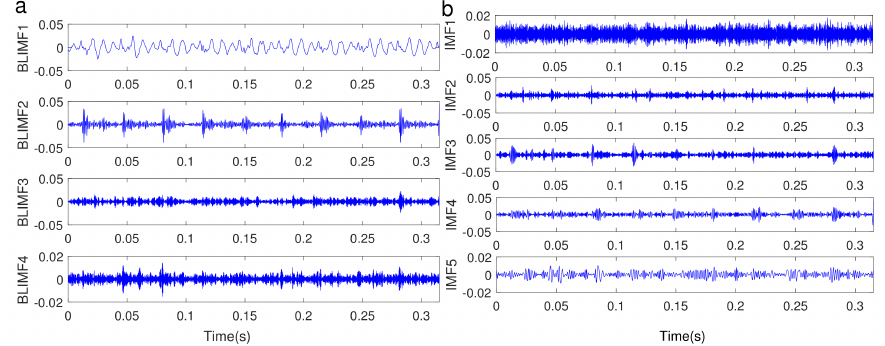
Figure 14. The decomposed BLIMFs using VMD ( a ) and IMFs using EMD ( b ) from the signal of the gear with a tooth root crack.